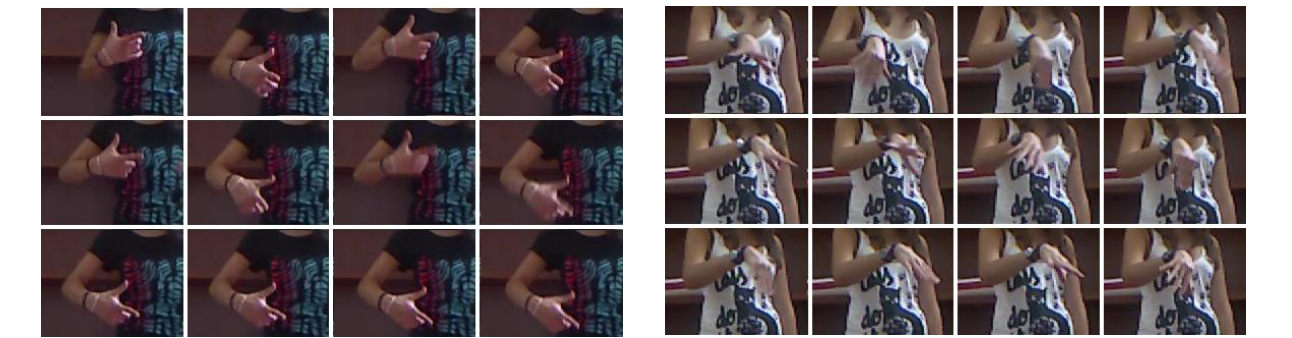
Figure 3. Sample00824, frames 164-211